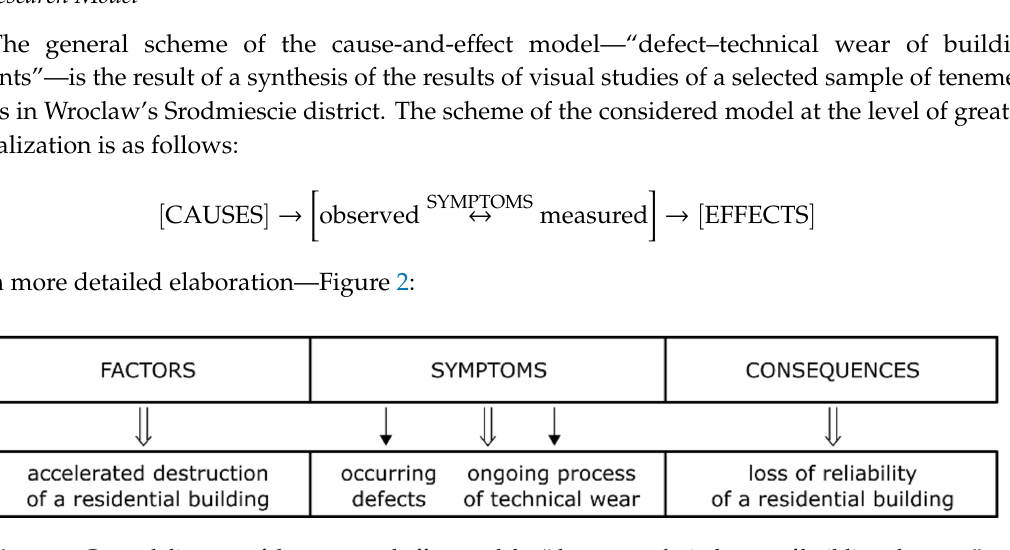
Figure 2. General diagram of the cause and effect model—“damage–technical wear of building